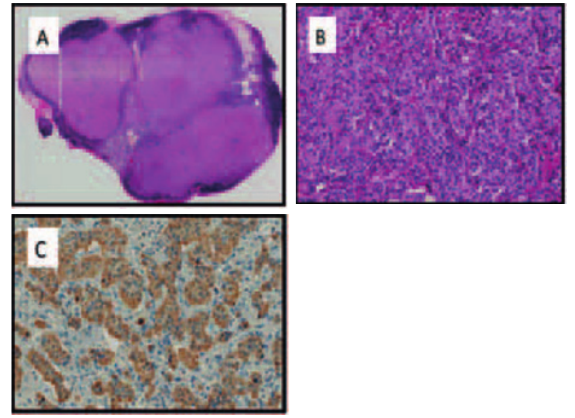
Figure 1. Metastasis of neuroendocrine carcinoma (A. HE 5x. Lymph node metastasis, detected fi rst; B. HE 100x. Lymph node metastasis: trabecular and nested structures of mo- notonous eosinophilic NE cells; C. IH 200x. Gastrin positiv- ity in cytoplasm of the tumor cells). HE – Hematoxylin and eosin staining; IH – Immunohistochemical